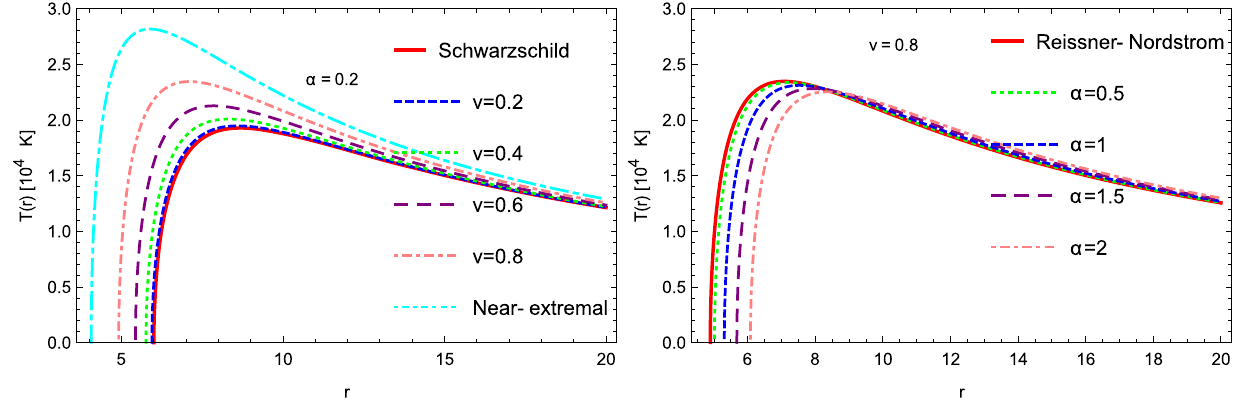
Fig. 3 Disk temperature T ( r ) for a static charged dilaton black hole with mass accretion rate ˙ M = 2 × 10 − 6 M (cid:10) year − 1 , for different val- ues of v , left panel and different values of α , right panel. The solid curves correspond to Schwarzschild ( v = 0) and Reissner-Nordstrom